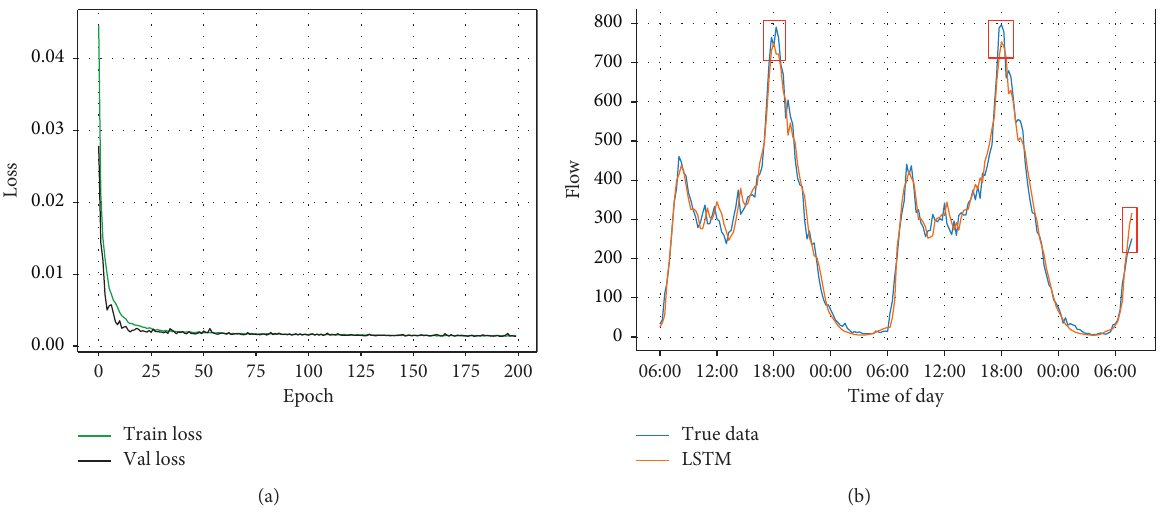
Figure 20: LSTM training and prediction. (a) LSTM loss function and (b) LSTM prediction